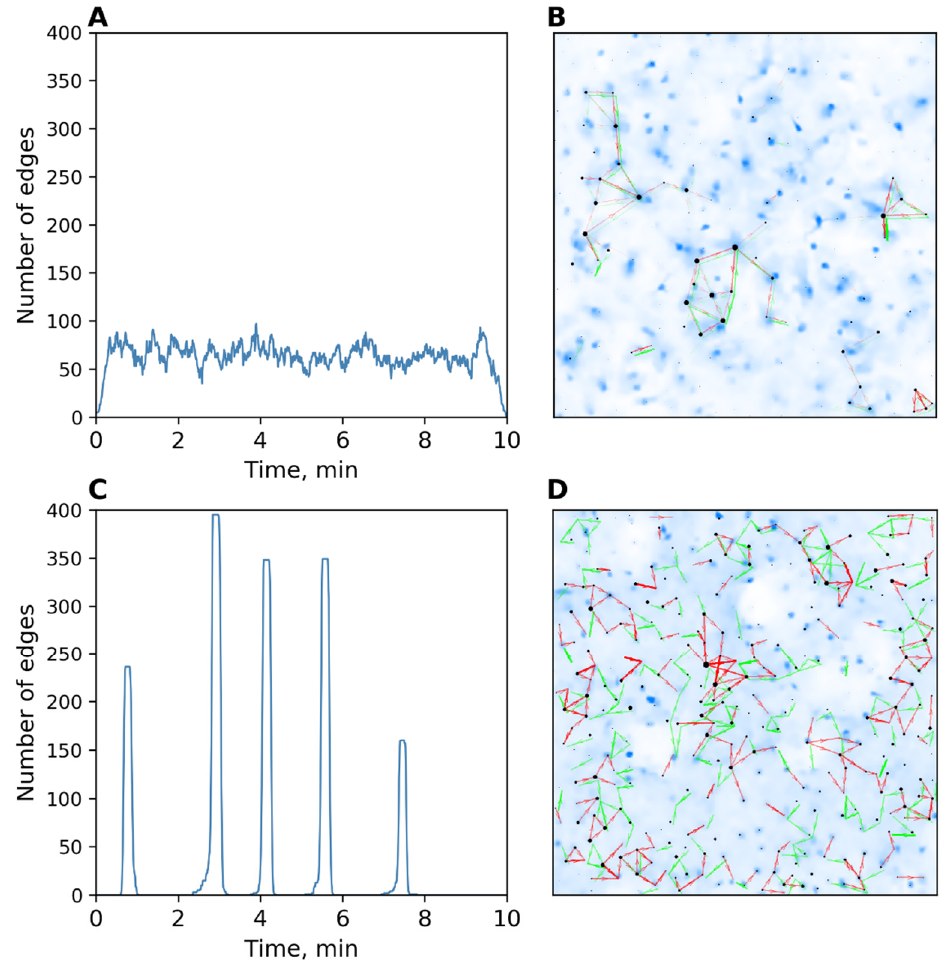
Figure 5. ( A ) Dynamics of the number of transmissions in an intact astrocytic culture. ( B ) Map showing the uniformity of transmissions in an intact astrocytic culture. ( C ) Dynamics of the number of transmissions in an intact neuronal culture. ( D ) Map showing the uniformity of transmissions in an intact neuronal culture.